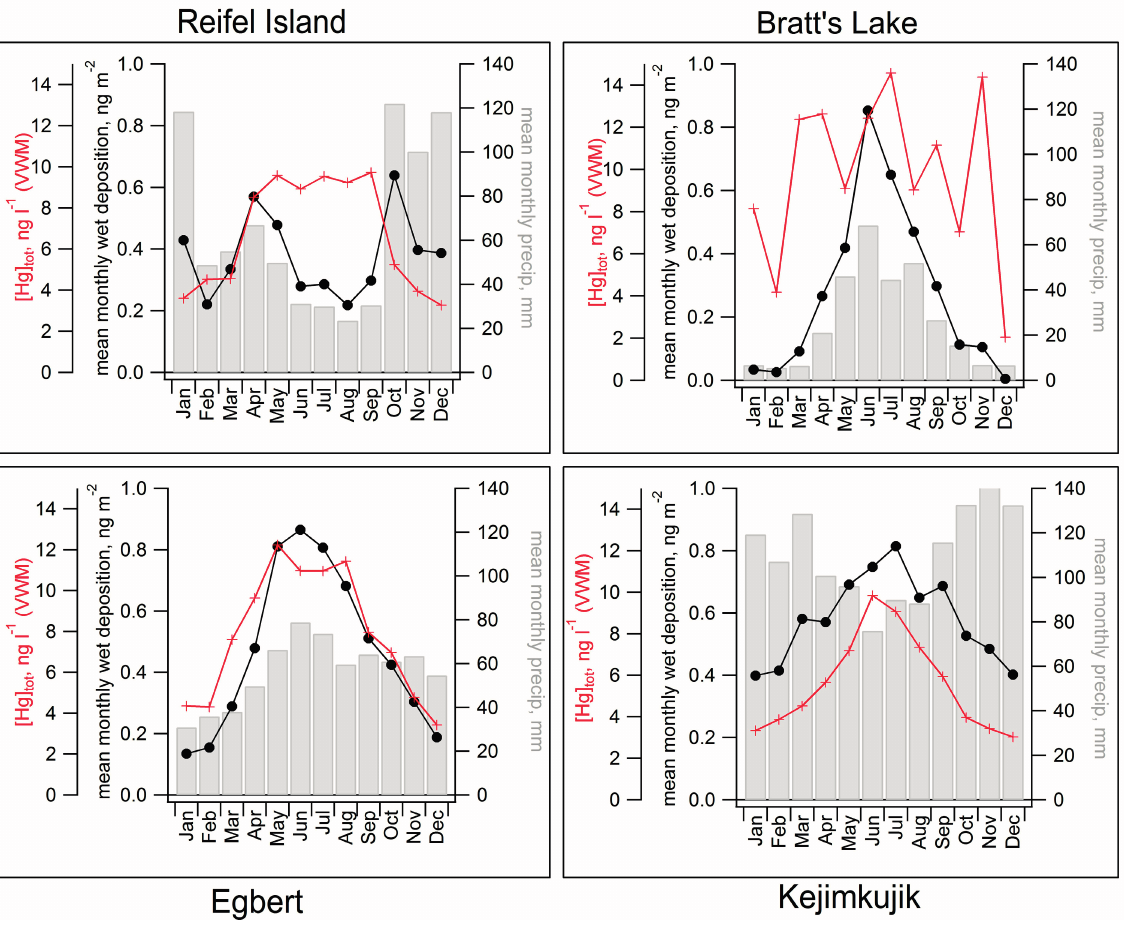
Figure 9. Seasonal cycles in monthly wet deposition (black), precipitation amounts (gray bars), and concentration of total Hg in precipitation (red) at four